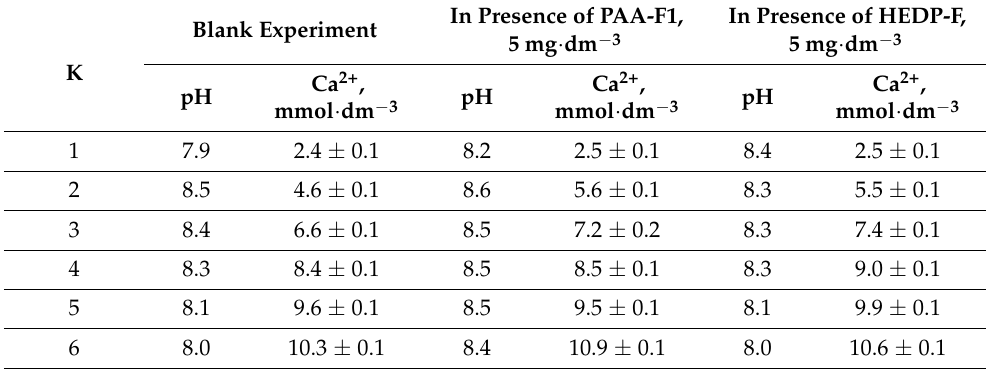
Figure 4. Variation of total calcium content in retentate + membrane ( a ); of calcium concentration in retentate in presence of HEDP-F ( b ); and in retentate in a blank run ( c ). Table 3. Variation of calcium concentration and pH in